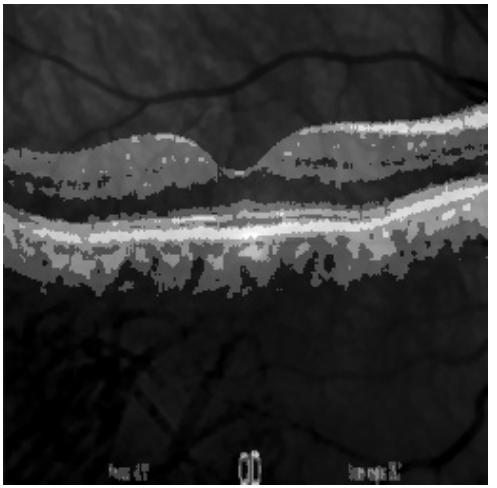
Fig. 13. Steganographic image obtained using MSB embed- ding process.